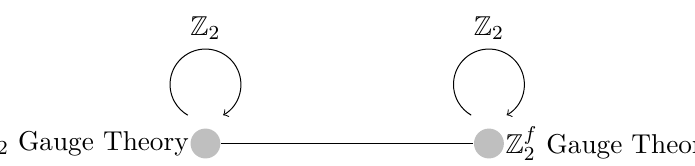
gauge theories can be enhanced as above. 2 gauge theory, and similarly for the Z f 2